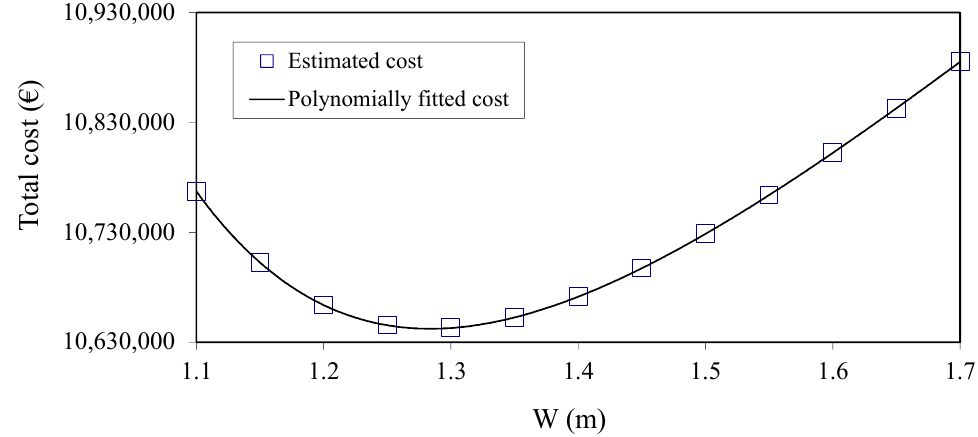
Figure 10. Total costs ( € ) as a function of the additional height of the crest element, W (m), when a third layer is added above the primary armor layer ( K D = 4).